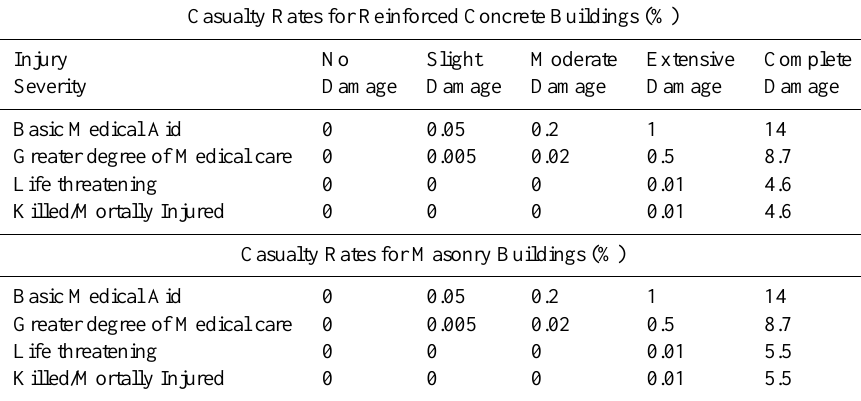
Table 4. Casualty rates for Reinforced Concrete Buildings and Masonry Buildings used as adapted from BU-ARC (2002).